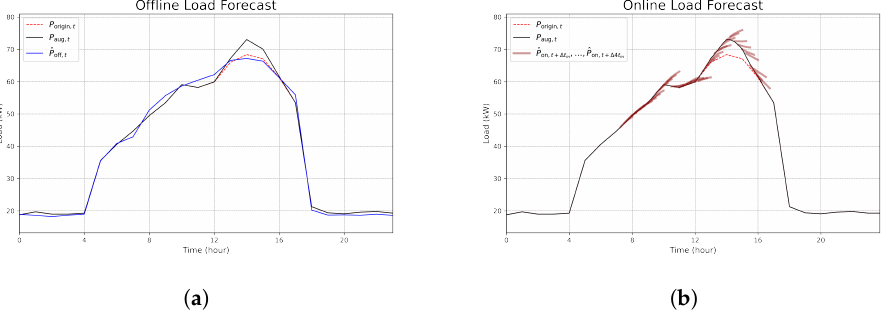
Figure 8. Offline and online load forecasts with positive synthetic uncertainties. ( a ) Offline load forecast, ( b ) Online load forecast.